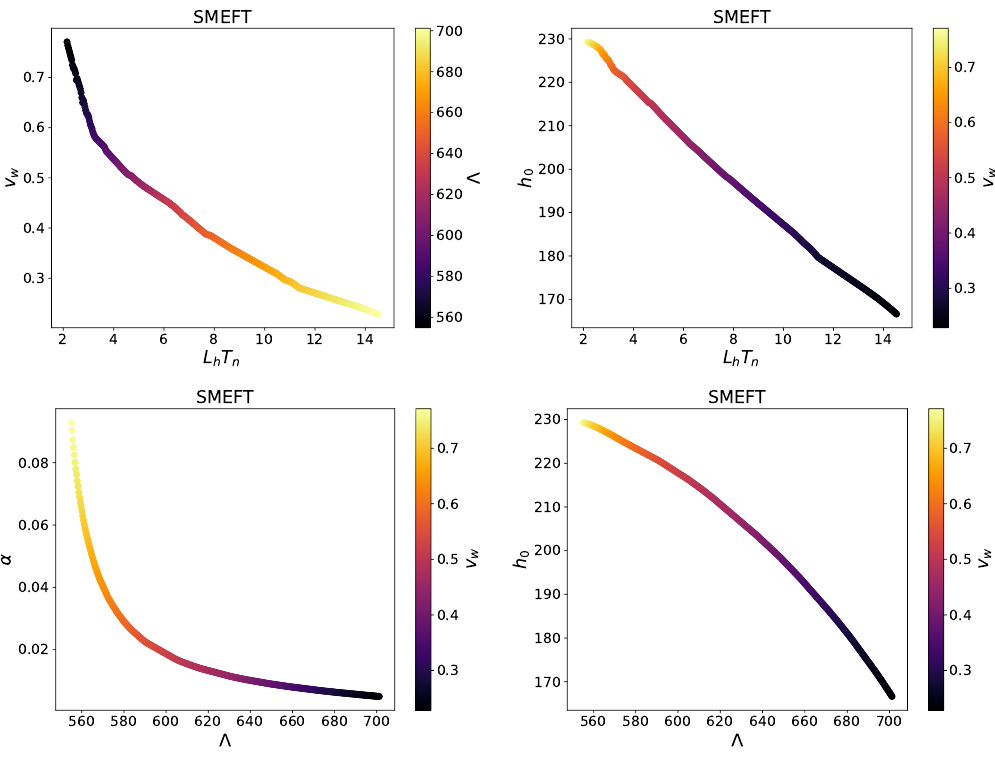
Figure 11 . Bubble wall properties in the SMEFT. Color bar shows the value of Λ in the upper left figure and of v in the rest of w